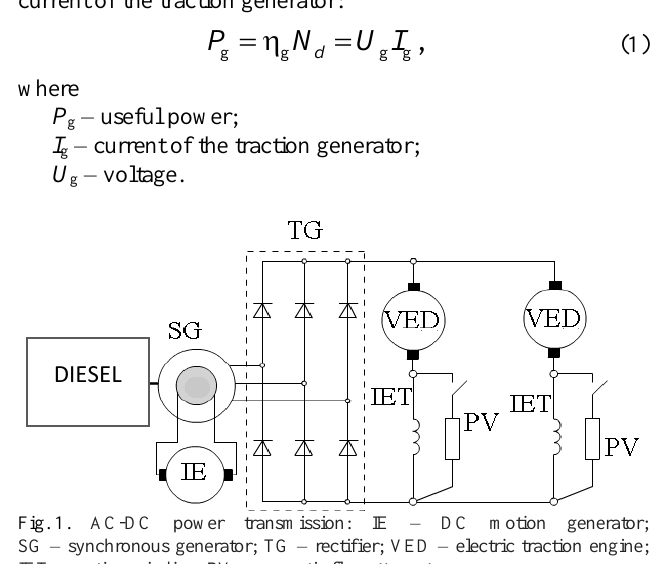
Fig. 1. AC-DC power transmission: IE – DC motion generator; SG – synchronous generator; TG – rectifier; VED – electric traction engine;